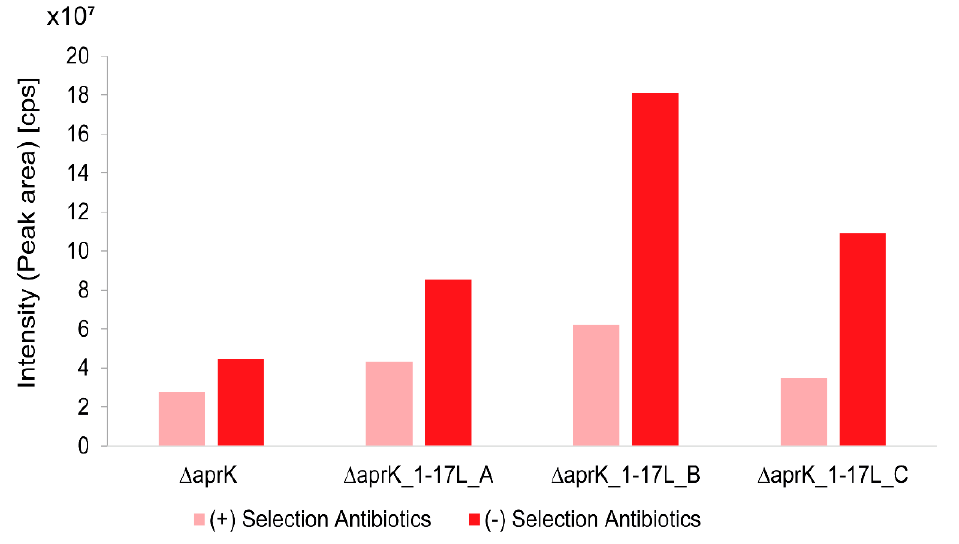
Figure 7. Production of carbamoyltobramycin (CTB) in the presence and absence of selection antibi- otics in M11 medium. The gene knockout mutant ∆ aprK and three isolates of ∆ aprK _1-17L ( A – C ) were analyzed. cps, counts per second (the number of ions that hit the detector per unit of time).